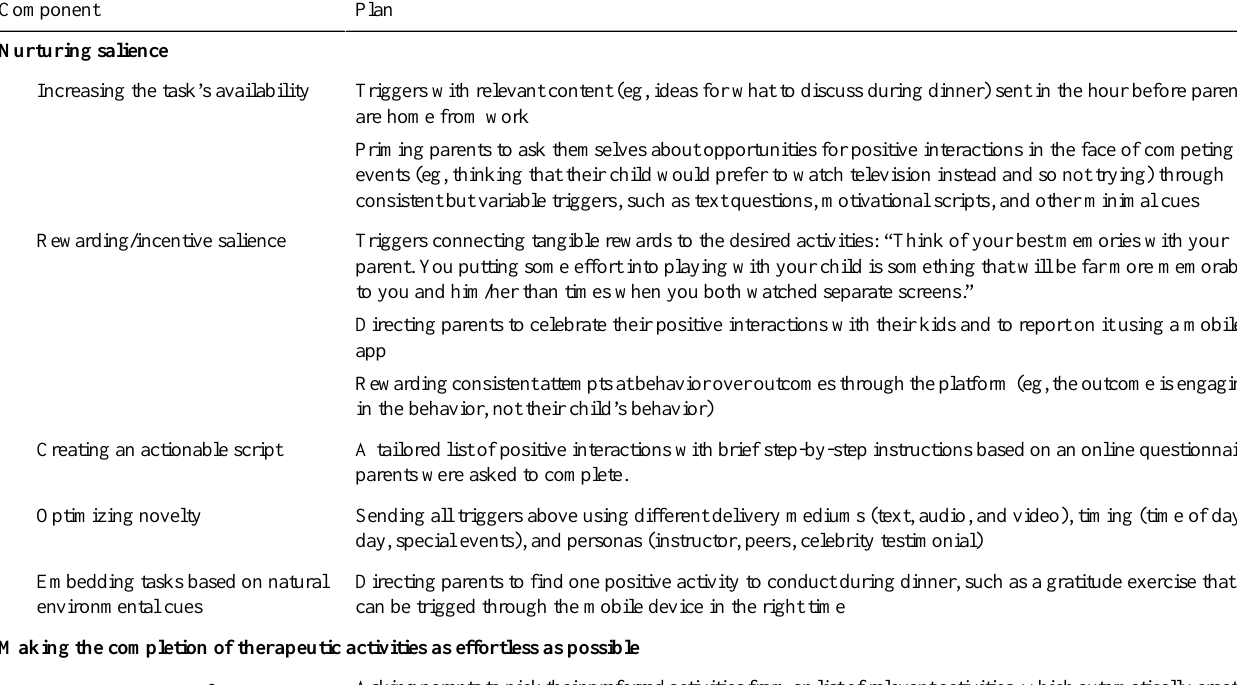
Table 2. Features increasing parent–child positive interactions based on the effort-optimized intervention